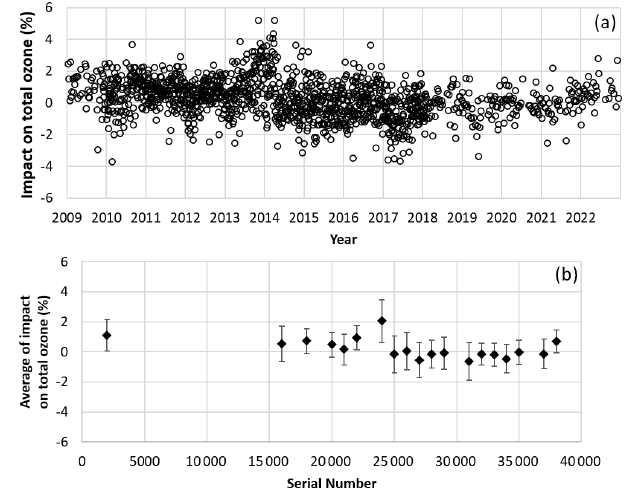
Figure 17. (a) Estimated impacts on total ozone values with use of the average pump-efficiency correction table. (b) Impacts on total ozone values for each serial number lot, with error bars indicating standard